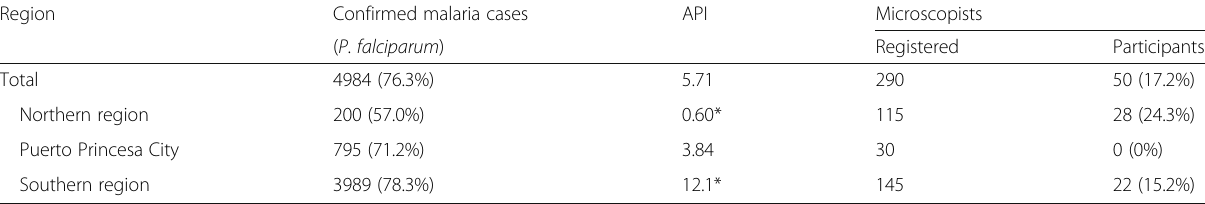
API annual parasite index *Chi-square test between the northern region and southern region ( p